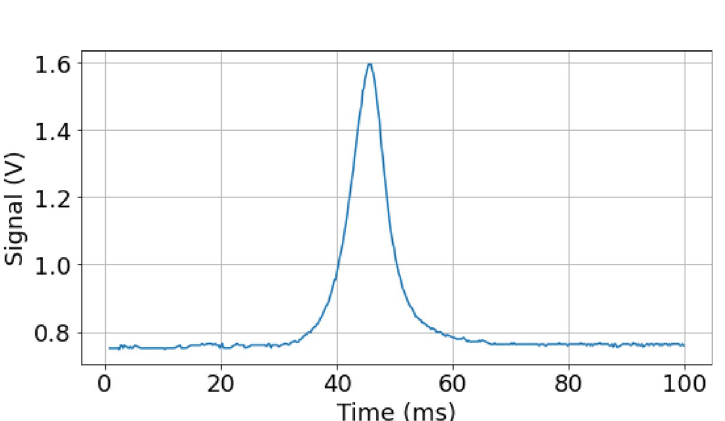
2 ) recorded by the detection